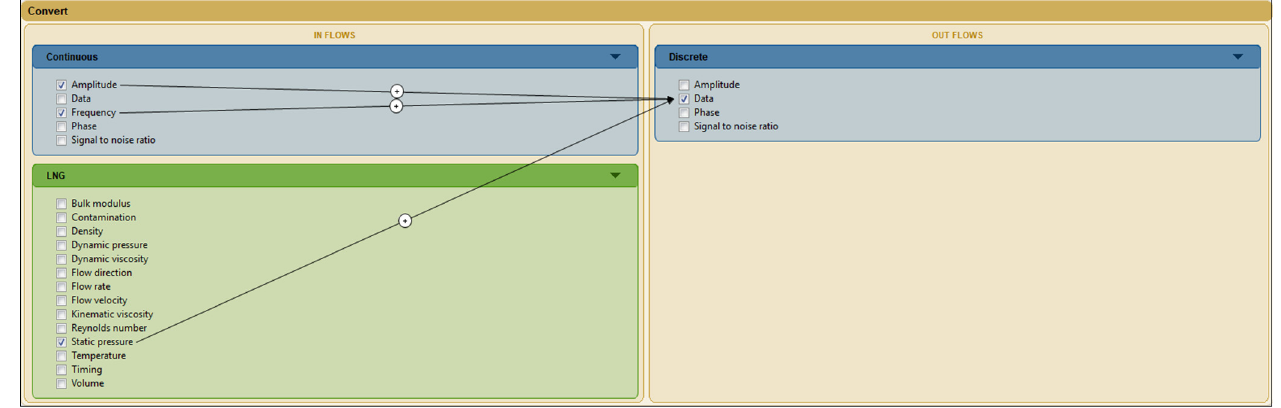
Figure 2. Liquefied Natural Gas (LNG) tank pressure sensor component